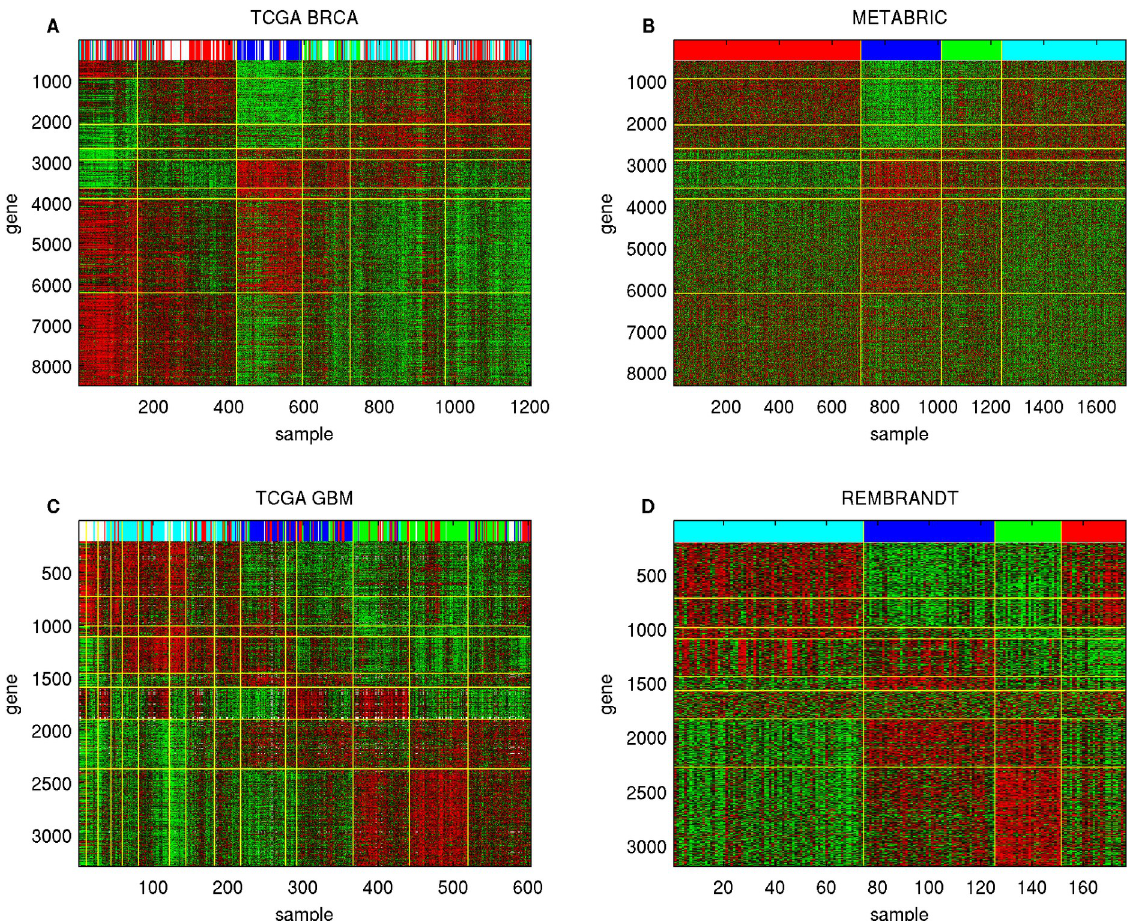
Fig 7. Sorted mRNA expression data of ( A ) TCGA BRCA and ( C ) GBM and the counterparts of ( B ) METABRIC and ( D ) REMBRANDT. Genes are sorted by their Super Module memberships and retain the same order in TCGA and external data. Samples are sorted by Sample Groups in TCGA data and by molecular subtypes in external data (luminal A, basal-like, HER2-enriched, and luminal B for METABRIC, and proneural, classical, mesenchymal, and neural for REMBRANDT). Sample subtypes are marked on the top row with the following codes: luminal A (red), basal-like (blue), HER2-enriched (green), and luminal B (cyan) for breast cancer, and proneural (cyan), classical (blue), mesenchymal (green), and neural (red) for GBM.